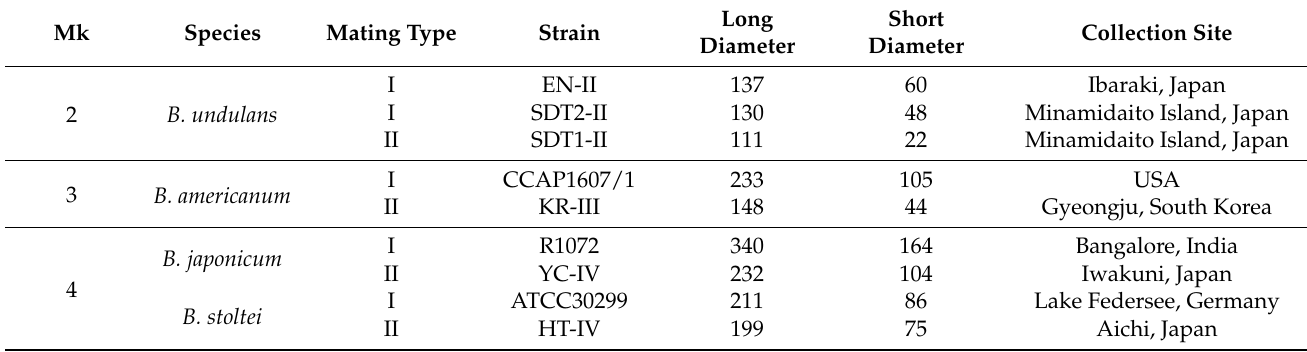
Table 1. Stocks used in this